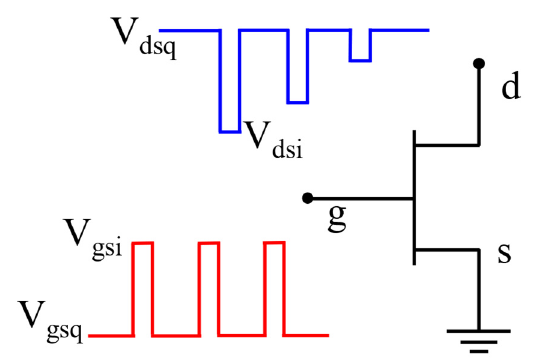
Figure 2. Signal settings for pulsed 𝐼 (cid:3005)(cid:3020) − 𝑉 (cid:3005)(cid:3020) measurement.